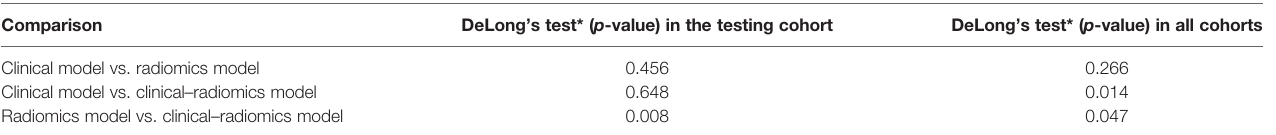
TABLE 4 | Comparison of the performance of the